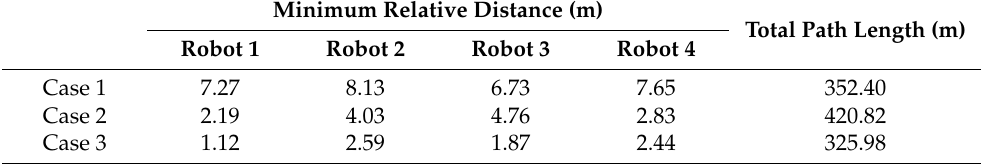
Figure 11. Testing results: Case 1. Table 6. Testing